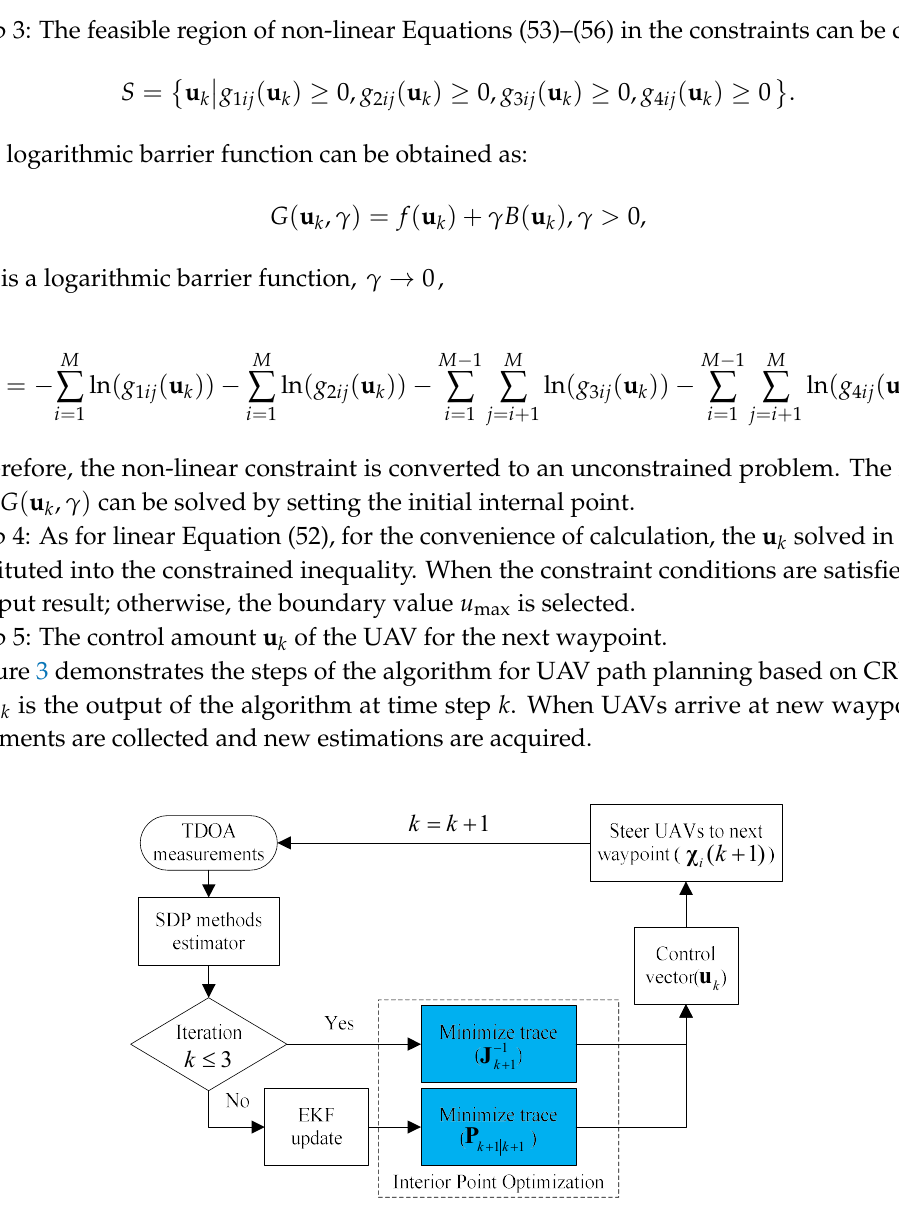
Figure 3. UAV path planning for localization based on CRLB (TDOA: time-difference-of-arrival; SDP: semidefinite programming; EKF: extended Kalman filter).